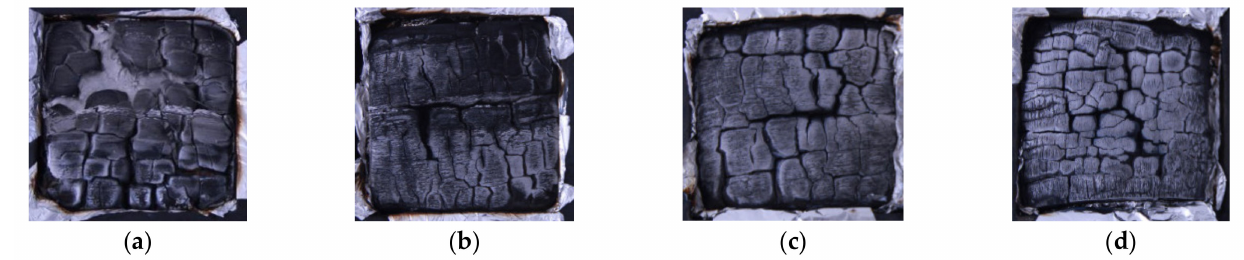
Figure 14. Residual cross-sections of a control ( a ) and BPF specimens with 0, 20, and 40% compression ratio ( b – d , respectively) after cone